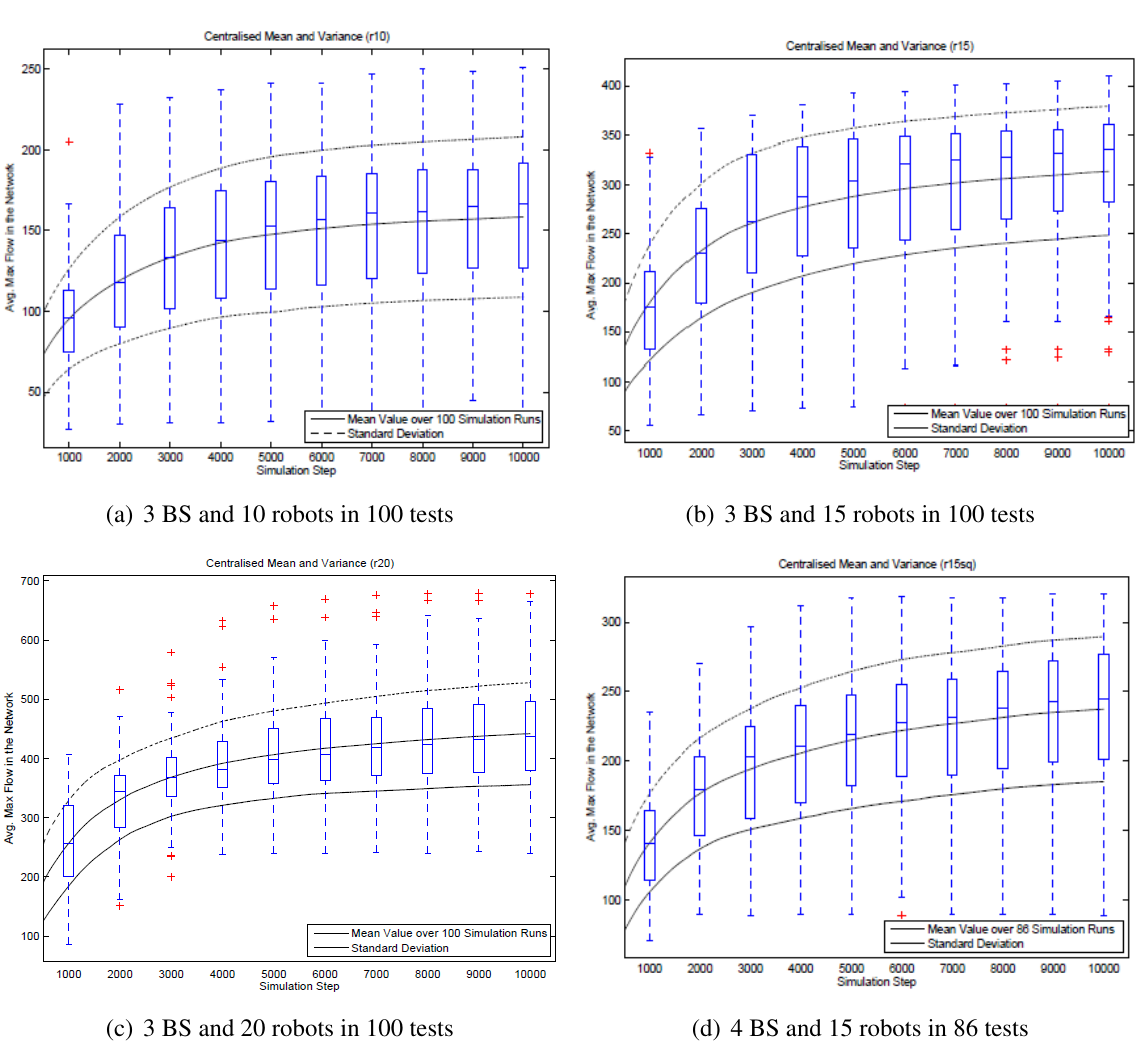
Figure 15. Average maximum flow of four